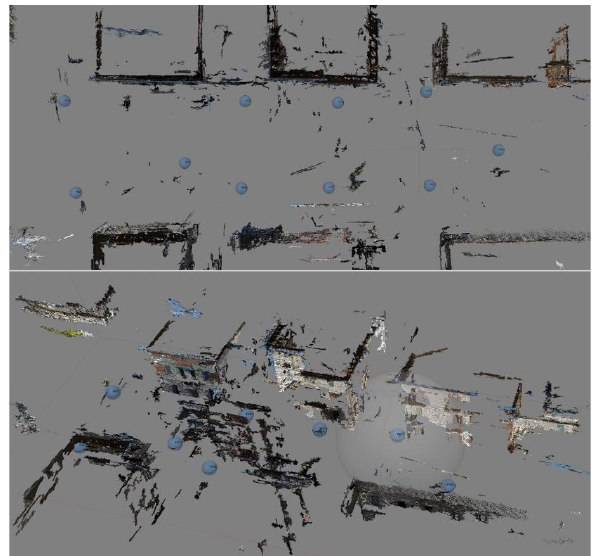
Figure 4: Alignment of the spherical panoramas from SLR camera on panoramic head and dense cloud processing.